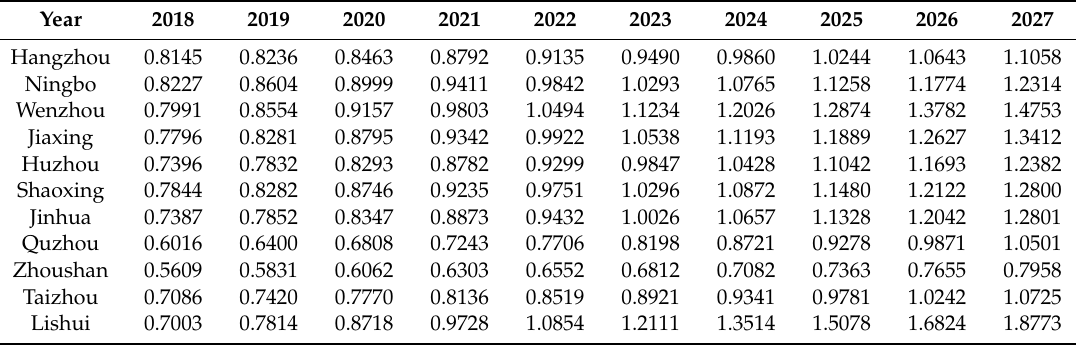
Table 5. GM (1,1) prediction results of UTACDI in 11 cities in